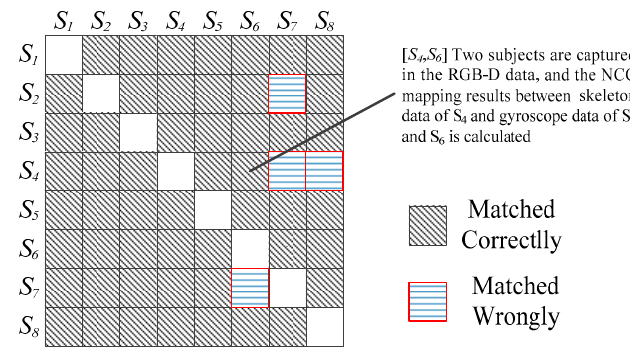
Figure 8. Results of NCC-based mapping.